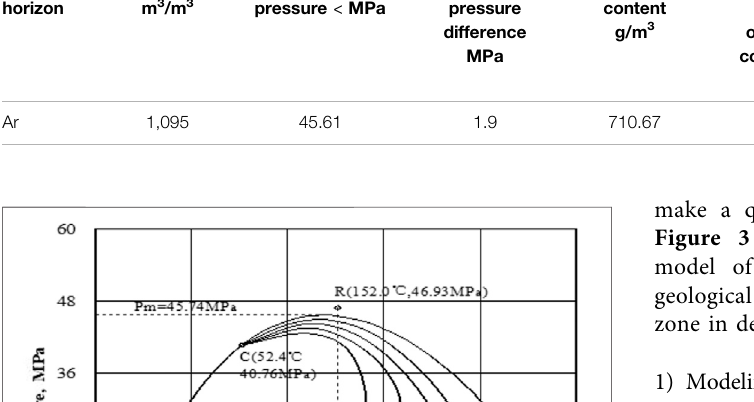
TABLE 2 | Gas condensate parameters of well BZ19-6-X (Liang et al., 2020). Sampling horizon